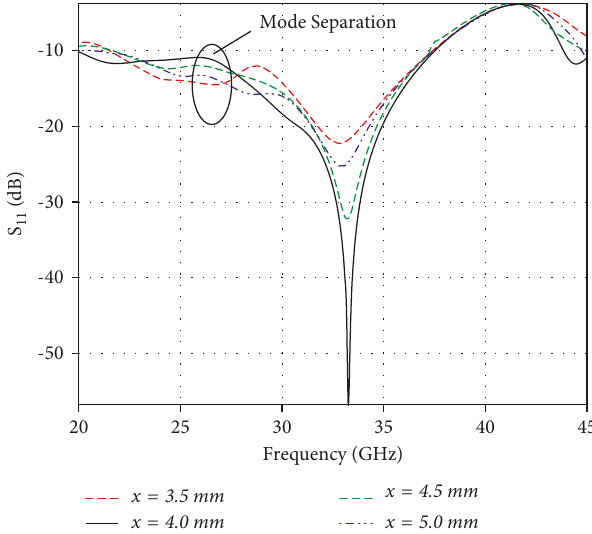
Figure 7: Simulated return loss characteristics of the proposed MIMO configuration for various values of distance “ x